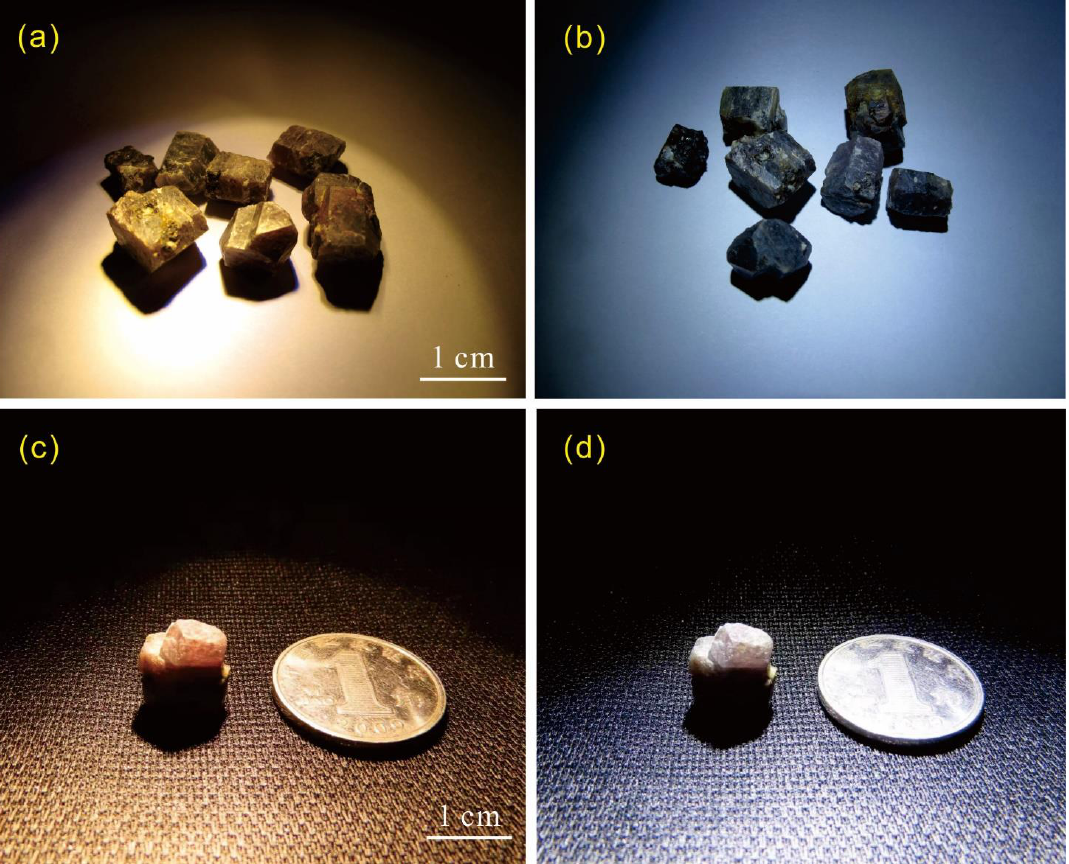
Figure 2. Color-change characteristics of Fuping sapphires, showing purplish blue color under sunlight ( a , c ), and light purplish red color under incandescent lamp light ( b , d ). (2) Refractive Indices Among the refractive indices of the six Fuping color-change sapphires, the No values of the samples FU-4 and FU-6 is the highest (1.772), by contrast, the No values of FU-1 and FU-2 is the lowest (1.765). The Ne values of the samples FU-4 and FU-6 is the highest (1.764), while the Ne values of FU-2 is the lowest (1.760). The samples of FU-4, FU-5 and FU-6 have the largest values of birefringence (0.008) and the sample of FU-1 has the lowest value of 0.003. The No of the color-change sapphire from Burma (MD-9) is 1.766, and Ne is 1.760 with a birefringence of 0.006.